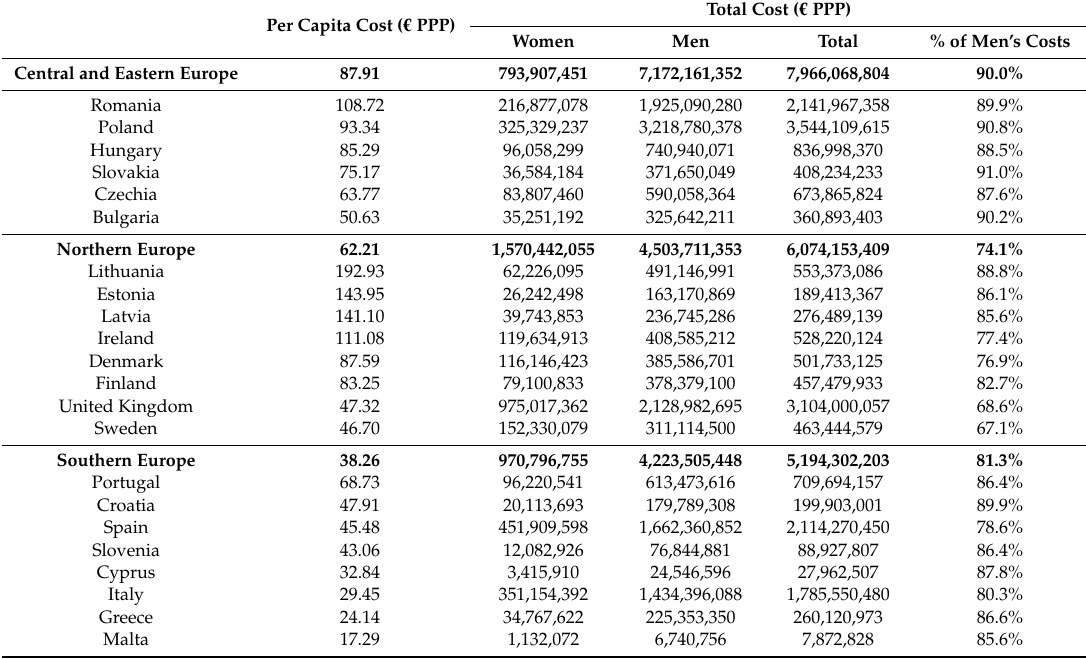
Table 2. Total and per capita production losses associated with alcohol-attributable mortality in 28 European Union countries,